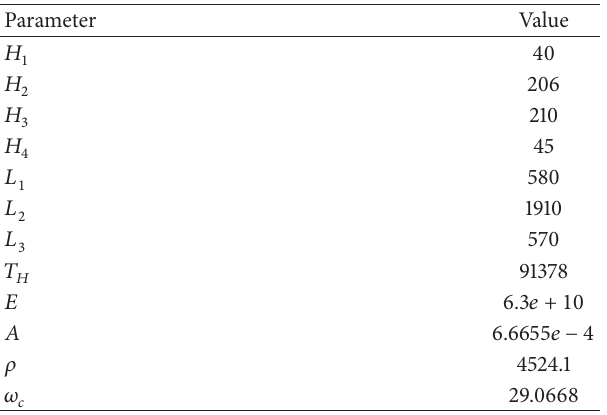
Table 1: The parameters of three-span cable.